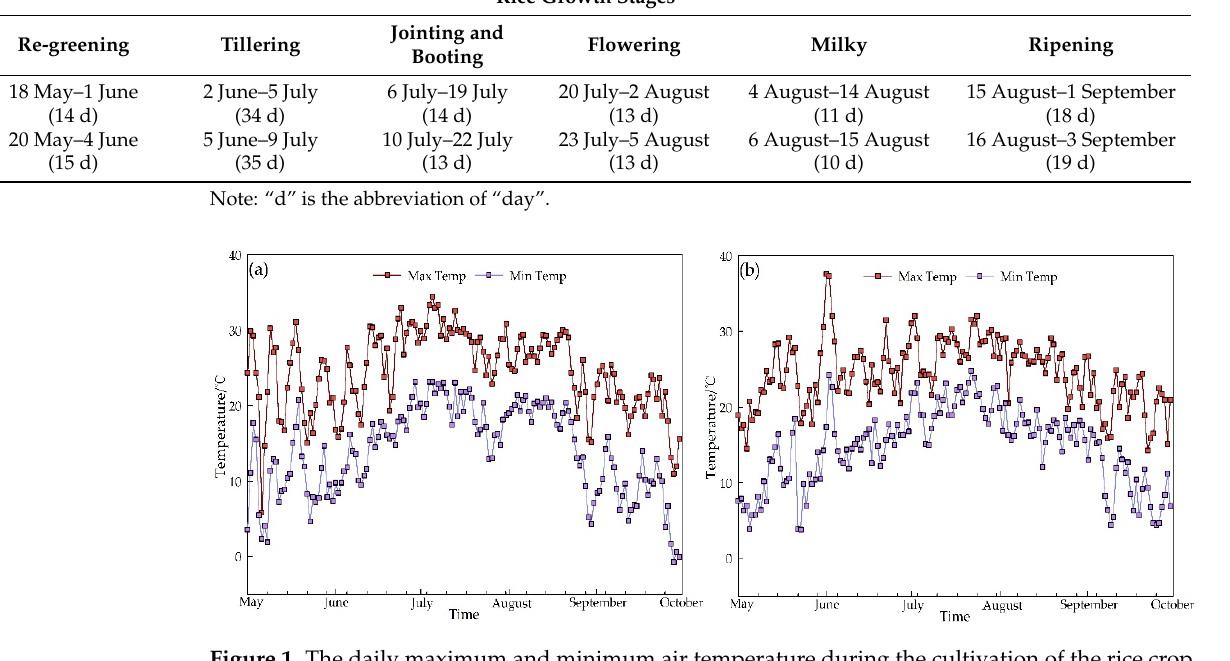
Figure 1. The daily maximum and minimum air temperature during the cultivation of the rice crop in ( a ) 2017 and ( b ) 2018. “Max Temp” is the maximum air temperature. “Min Temp” is the minimum air temperature.